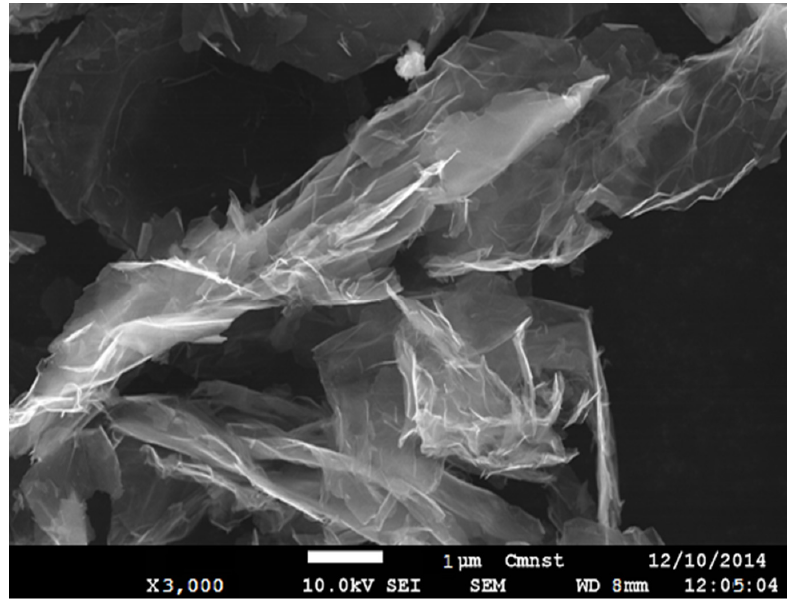
Figure 1. Scanning electron microscope image of pristine graphene nanoplatelets.